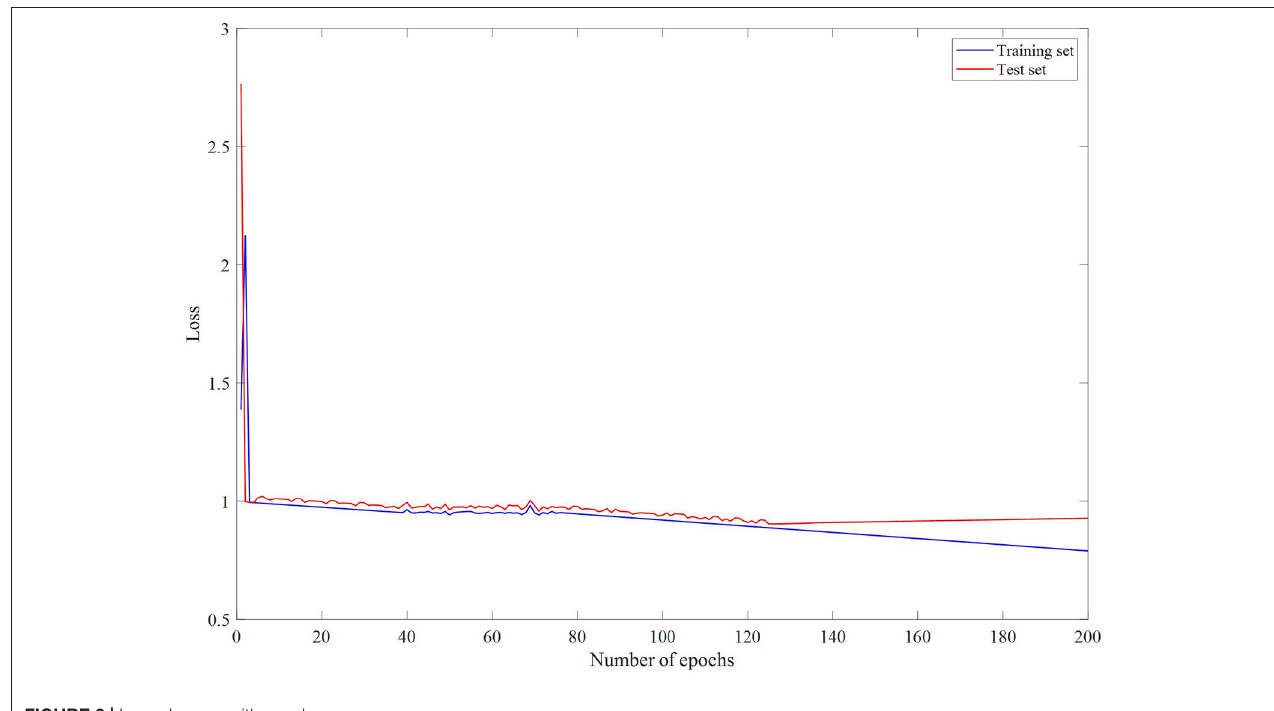
FIGURE 2 | Loss changes with epochs.